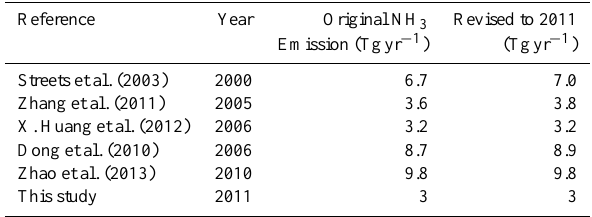
Table 3. Comparison of NH 3 emissions from fertilizer use in our study with other published